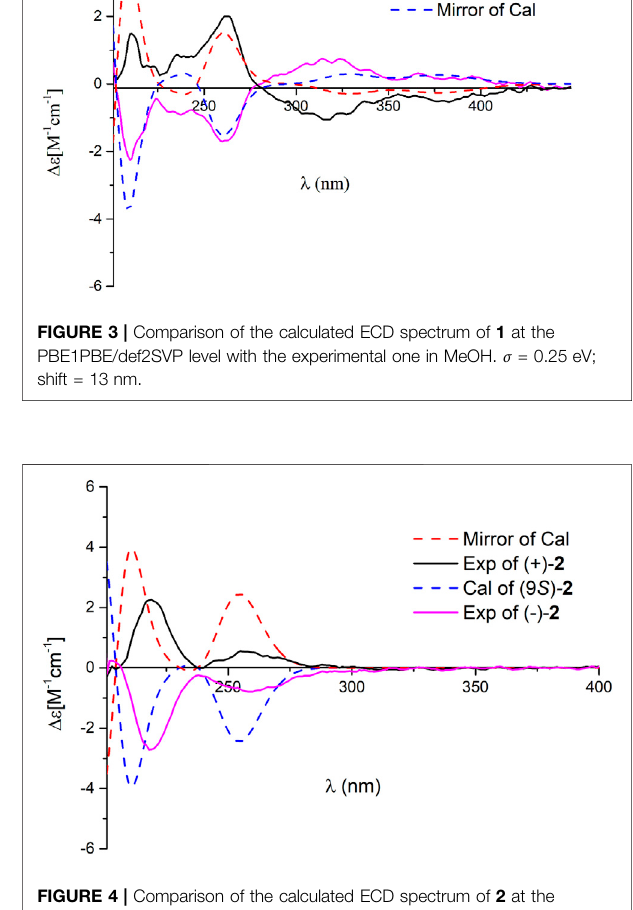
Frontiers in Chemistry |